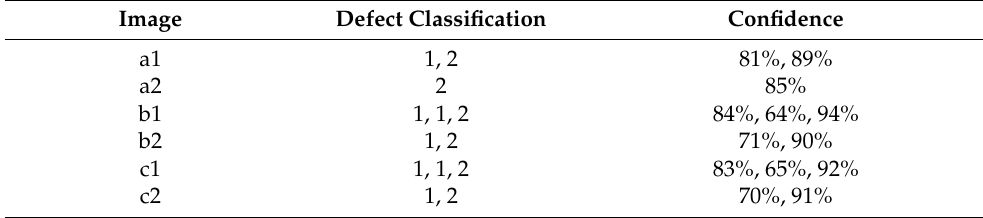
Table 3. The detection results of three network